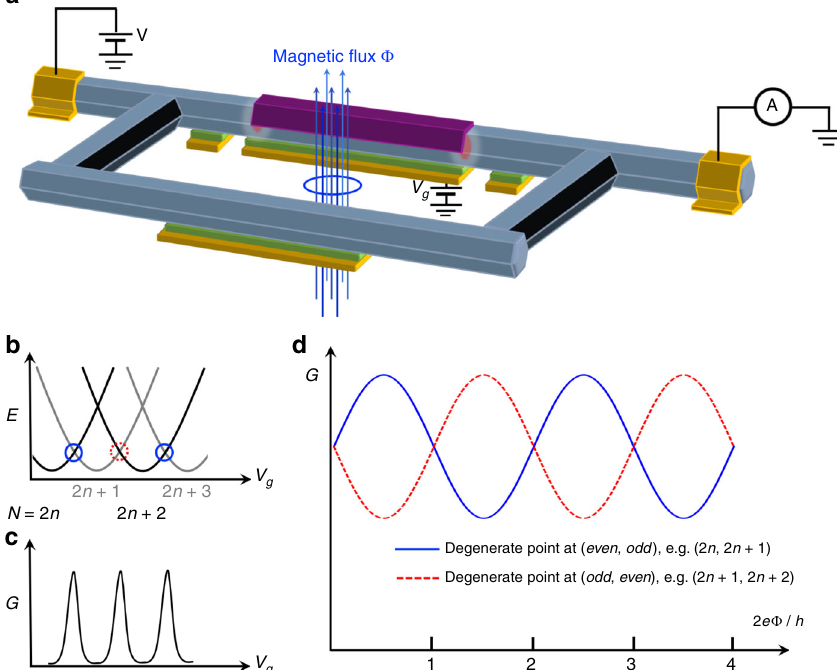
Fig. 5 Majorana-Fu-Interferometer. a Schematic experimental setup of a Majorana-Fu-interferometer device with two coherent electron traveling paths: (1) Majorana island with a fi nite charging energy in the upper path; (2) semiconductor nanowire in the lower path. b Energy diagram of the island hosting MZMs where N represents the electron number on the island, tuned by V g . c Zero bias conductance of the Majorana island (with the lower path pinched off) shows 1 e -periodic Coulomb blockade peaks, indicating coherent ‘ teleportation ’ of single-electron processes. d Turning on the lower path as a reference channel, the zero bias conductance shows Ahronov-Bohm oscillations as a function of magnetic fl ux. The blue and red AB oscillations are for V g fi xed at two successive Coulomb peaks, i.e., the two charge degenerate points: even to odd (blue) and odd to even (red). The π phase shift between different parity states can be used for the readout of Majorana qubit